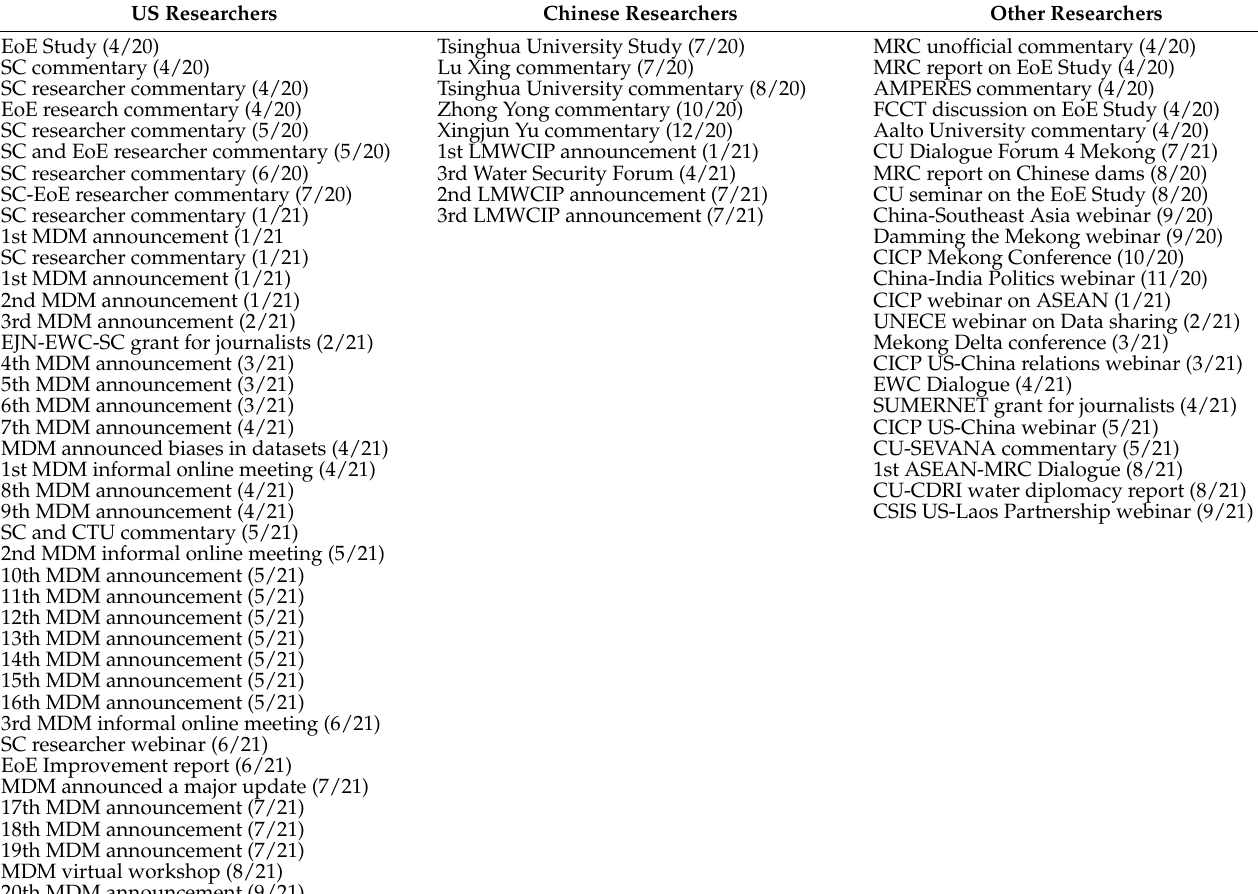
Table 4. List of research inputs politicizing and depoliticizing the Chinese mainstream dams